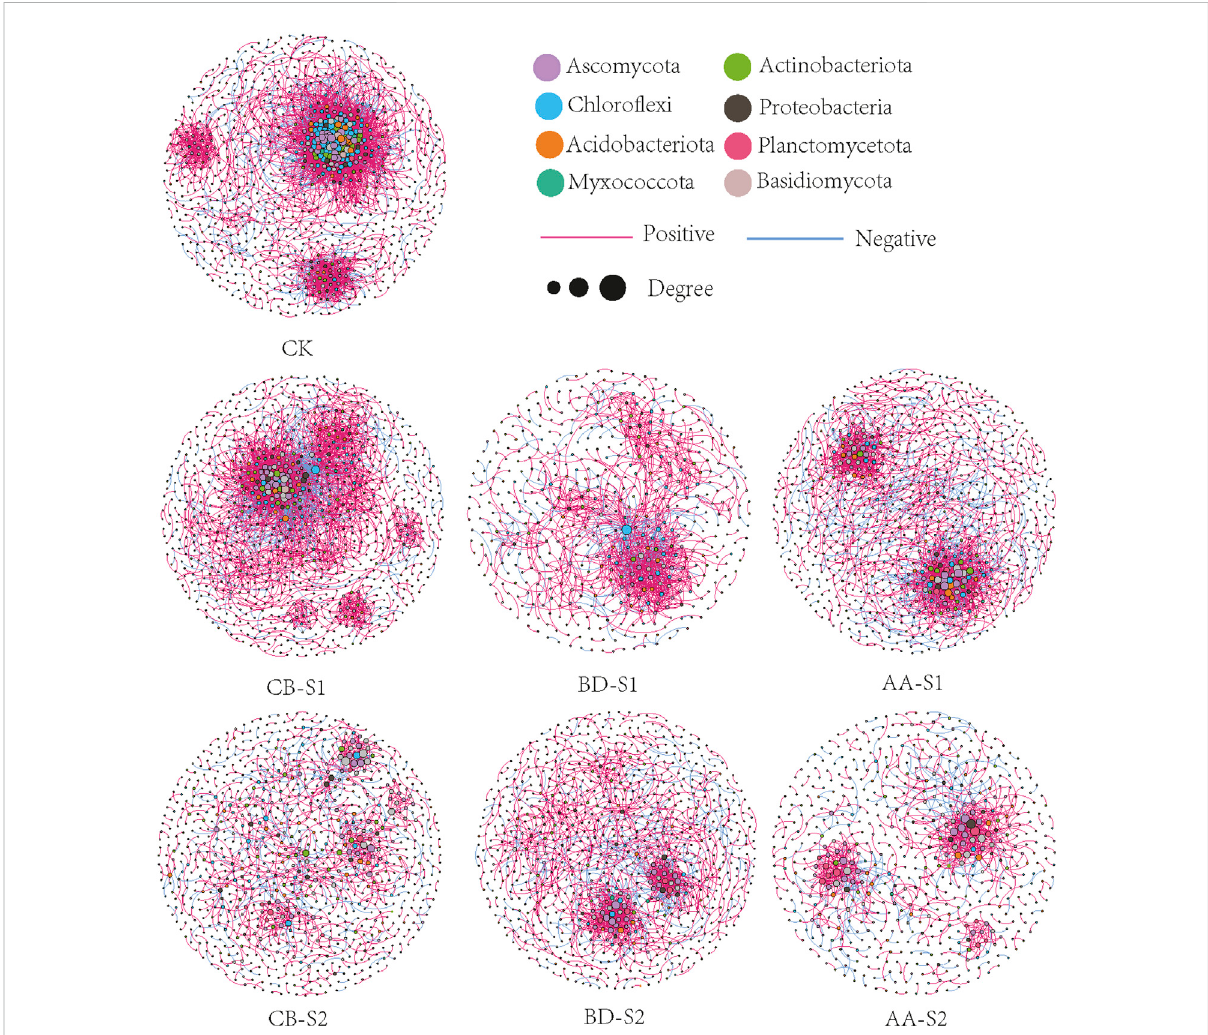
FIGURE 3 Co-occurrencenetworksofsoilmicrobialcommunityforbaresoilsandrhizospheresoilsofthreemetal-tolerantplantsatS1andS2.Thenodes are colored by thephylum level, and size of each node is proportional to its degree. The line between each pair of nodes represent positive(red) and negative (blue) correlation with p < 0.01 and |r| > 0.9. CB, BD and AA respectively represented C. breviculmis , B. davidii , and A. annua . S1, sample site on the zinc smelter waste heap; S2, sample site around the zinc smelter waste